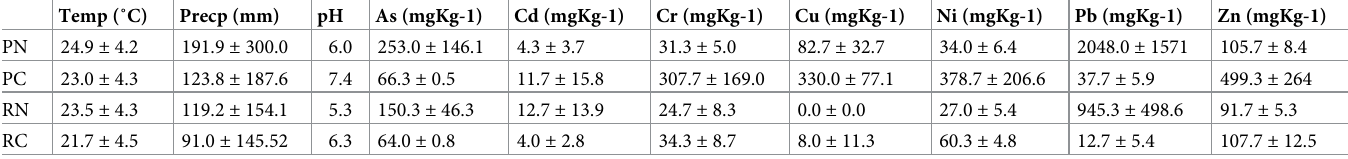
Data are the means ± standard deviation. Temp, annual mean temperature; Precp, annual mean precipitation. PN, Nantou polluted area; PC, Changhua polluted area; RN, Nantou remediated area; RC, Changhua remediated